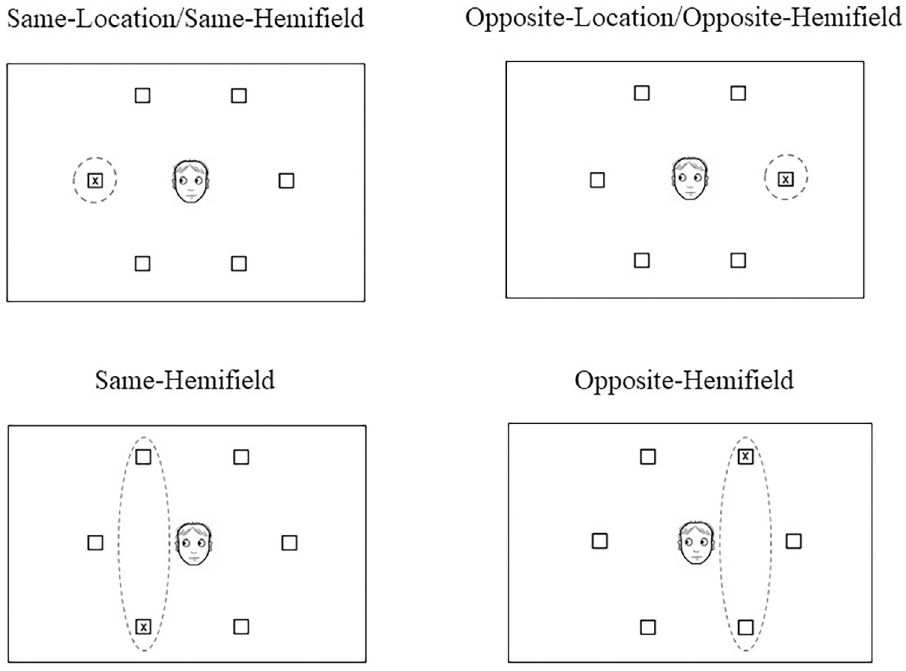
Fig 2. Illustration of the four types of cue-target relation of Experiment 1. The images represent the gaze-cue in a placeholder-present condition. The cue-target relation for the placeholder-absent condition was the same, with the exception that no placeholder boxes were presented on the